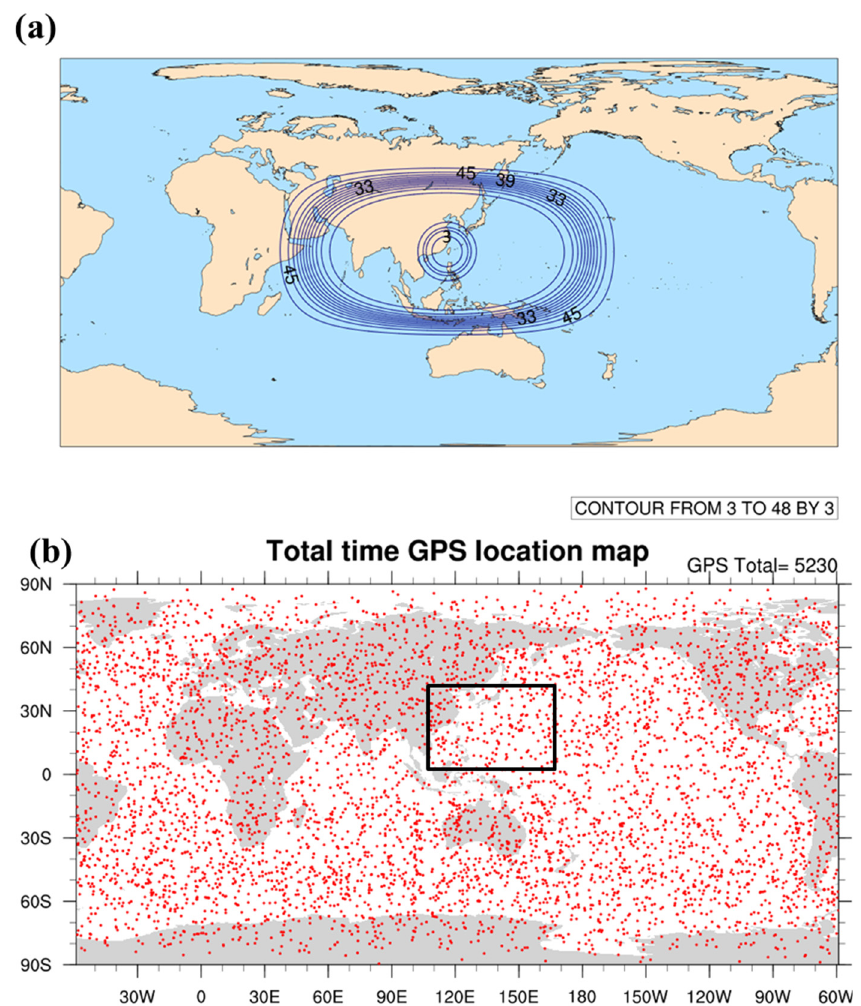
Figure 2. ( a ) The approximate mesh resolution of MPAS-60-15-3 km indicated by the contours at an interval of 3 km, and ( b ) the geometric locations of GPS RO soundings from 0000 UTC 2–4 July 2016 over the global MPAS mesh. The local region indicated by the black box is used for verification.